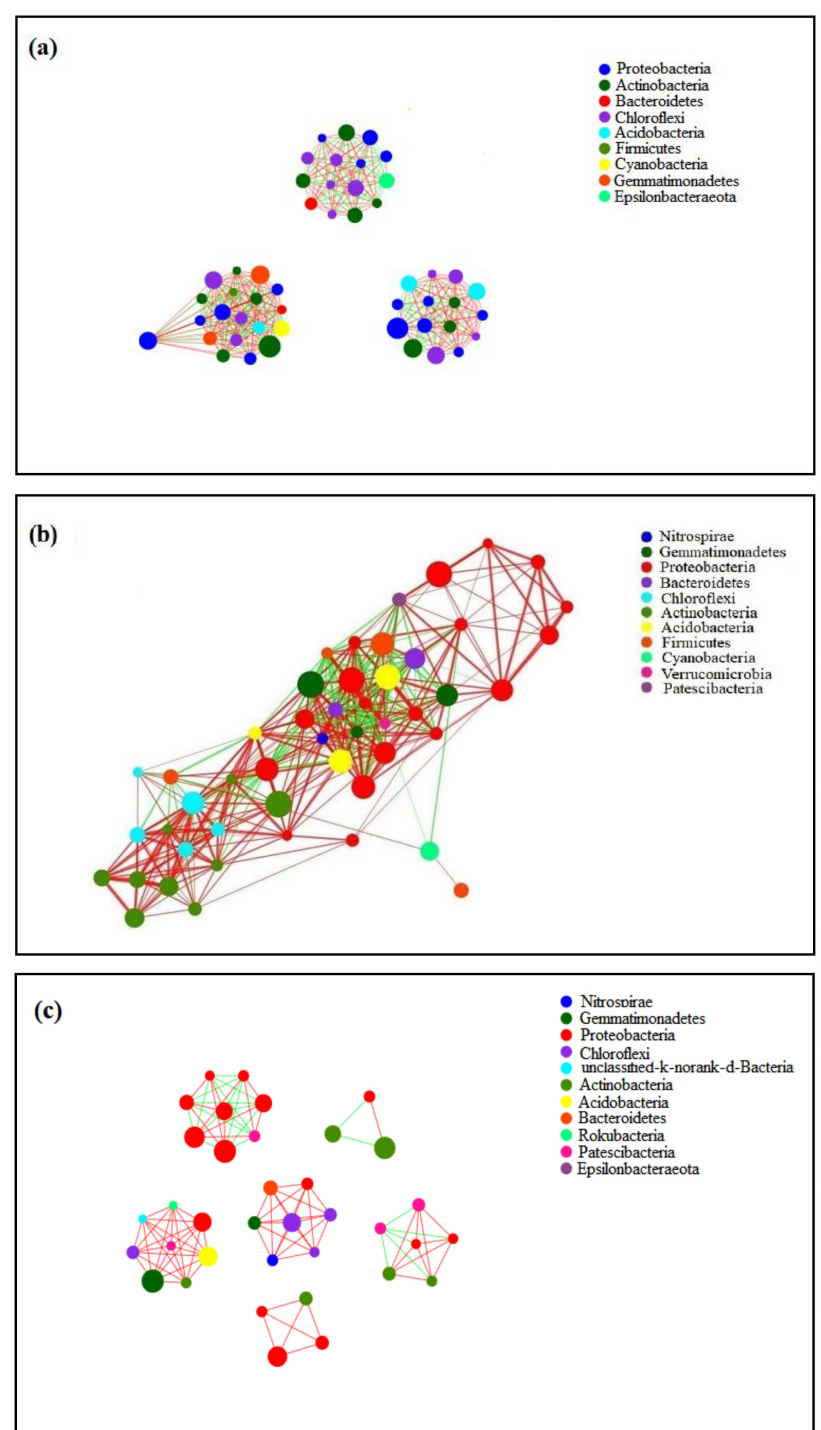
Figure 6. Symbiotic network diagram of soil rhizosphere microbial community (( a ) I. tectorum sole- cultivated pattern under Cr stress ( b ) I. tectorum two-cultivated pattern under Cr stress; ( c ) I. tectorum three-cultivated pattern under Cr stress). The size of nodes in the figure indicates the abundance of species, and different colors indicate different species. The line’s color indicates a positive and negative correlation, red indicates a positive correlation, and green indicates a negative correlation. The thickness of the line indicates the correlation coefficient. The thicker the line, the higher the correlation between species. The more lines, the more closely related the species is to other species.